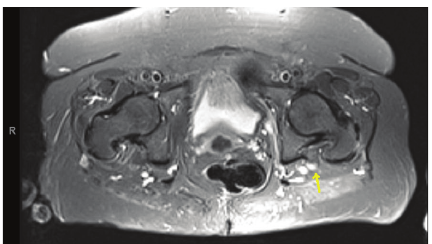
Figure 1: Axial MRI-STIR of the pelvis without contrast. There is asymmetric high T2 signal and enlargement of the left sciatic nerve as seen on axial STIR image localized to pelvic region (marked by yellow